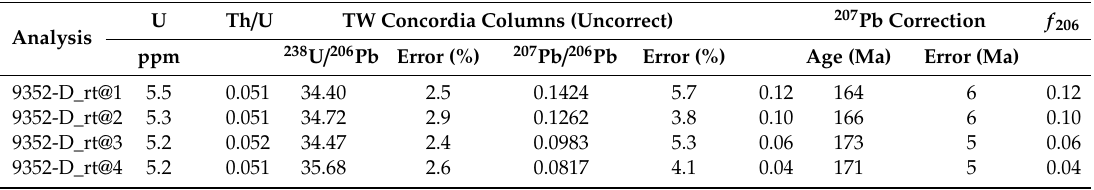
Figure 8. U–Pb age concordia diagram for rutile from the site 73 Menominee kimberlite. Table 4. Rutile U–Pb data analyzed by a CAMECA IMS 1280HR ion microprobe.